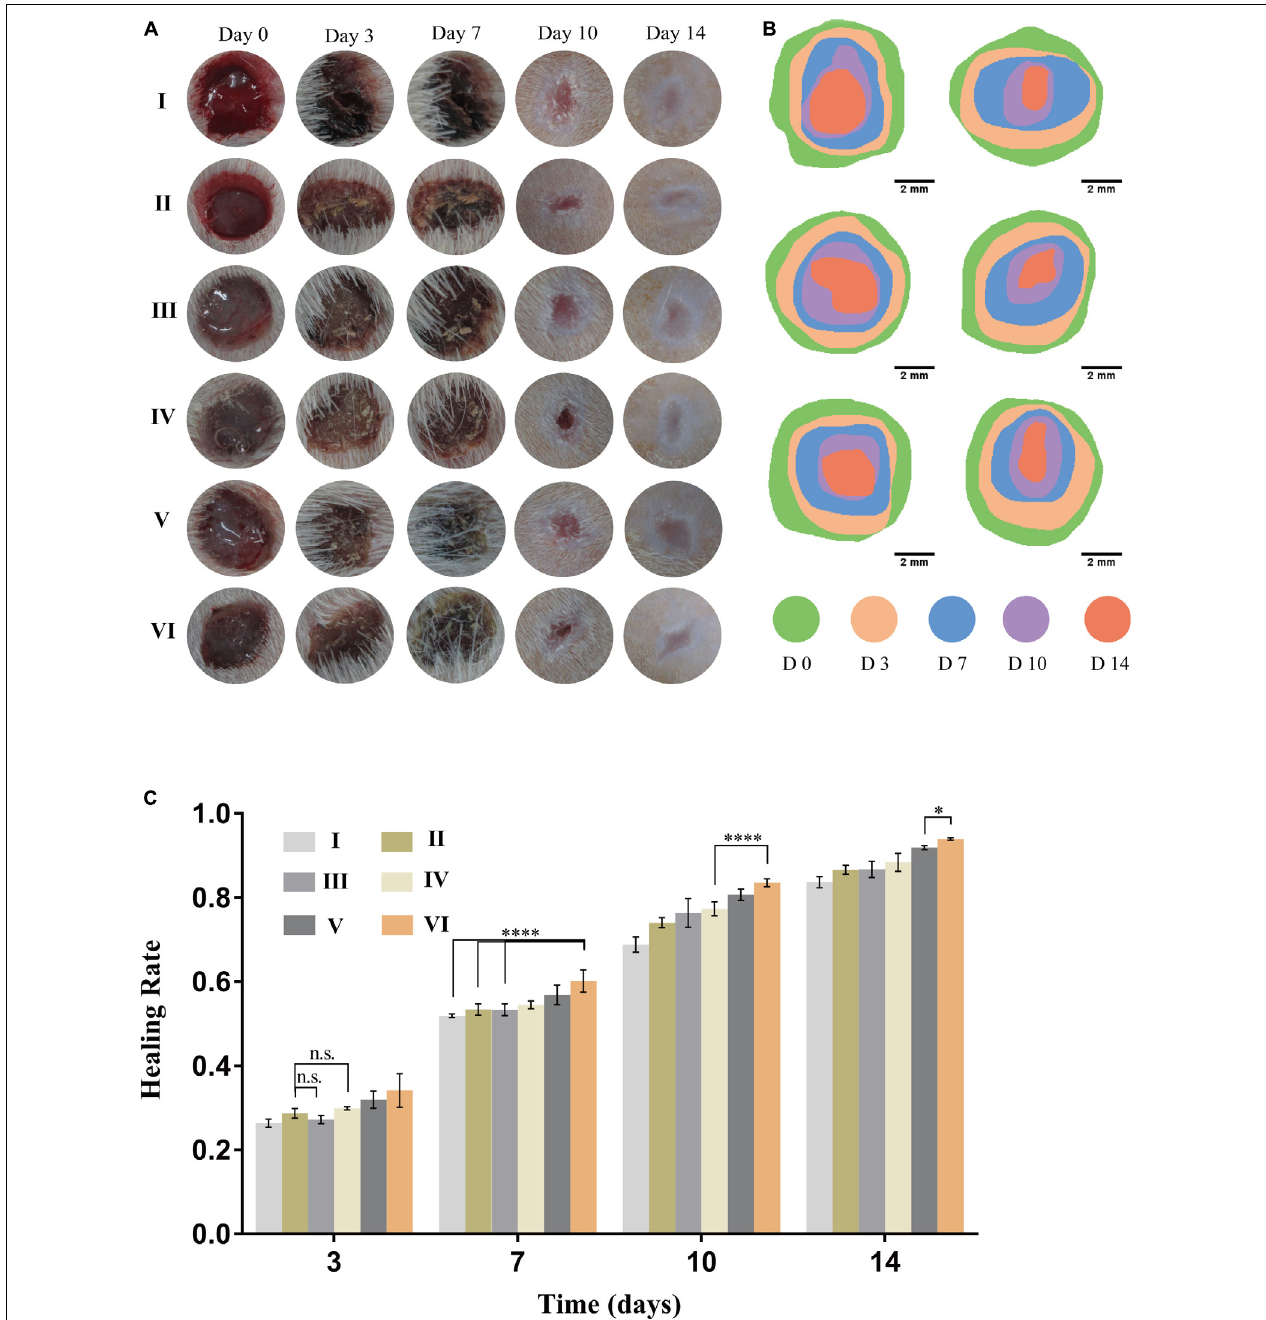
FIGURE 6 | Performance of hydrogels on wound healing. (A) Representative gross views of wounds at predetermined time points. (B) Traces of wound closure area for 14 days. (C) Healing rate for each group, n = 5, data = mean ± SD. (I: blank control; II: NIR; III: HA hydrogel; IV: HA hydrogel + NIR; V: CuS/HA hydrogel; and VI: CuS/HA hydrogel +